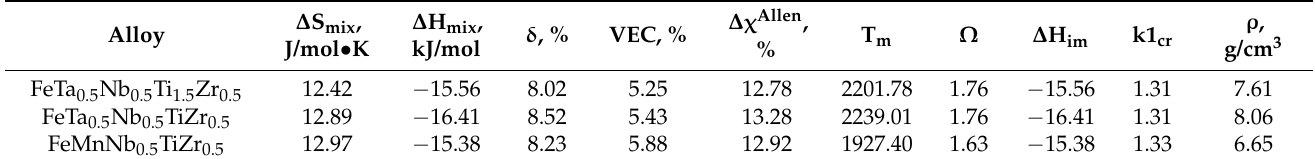
Table 2. Thermodynamic and kinetic criteria for the formation of optimal CCAs.